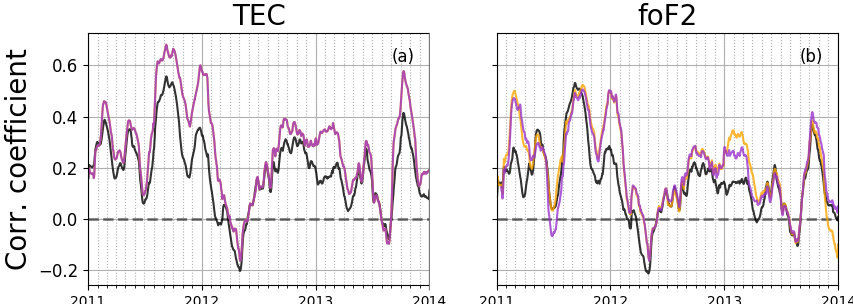
Figure 8. The plots show the correlation coefficients of the ionospheric parameters TEC (a) and fo F2 (b) with integrated EVE fluxes (6 to 105nm) for Darwin (black), Camden (orange), and Canberra (purple). All parameters were analyzed at an hourly resolution using a time window of 90d and a step size of